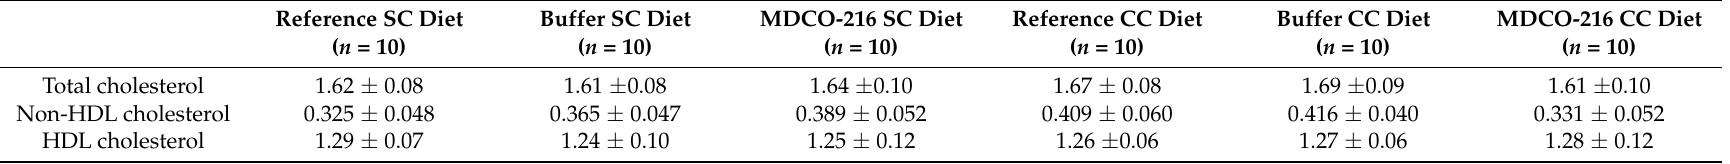
Table 2. Total cholesterol, non-HDL cholesterol, and HDL cholesterol plasma levels in C57BL/6 mice at time of